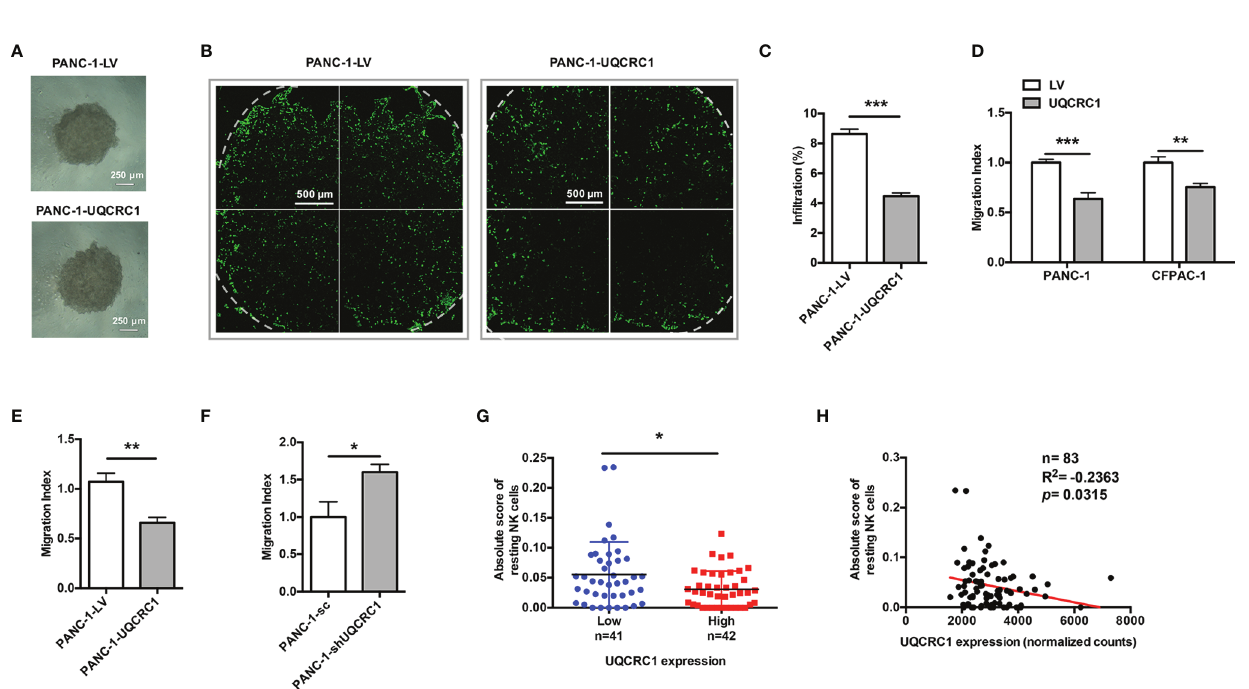
FIGURE 2 | UQCRC1 expressed in cancer cells impairs the migration and in fi ltration of NK cells into PC. (A) Microscopic images of UQCRC1-overexpressing and control PANC-1 spheroids (magni fi cation 4x). Scale bar = 250 m m. (B) The confocal microscopic images of PANC-1 spheroids after co-culture with NK-92MI cells at an E: T ratio of 2: 1 for 24 h. Scale bar = 500 m m. (C) Flow cytometric analyses of the proportions of NK-92MI cells in fi ltrated in the spheroids after 24 h of co- culture. (D) Transwell migration assay of NK-92MI cells toward the culture supernatant from UQCRC1-overexpressing or control PC cells. (E) Transwell migration assay of primary NK cells toward the culture supernatant from UQCRC1-overexpressing or control PANC-1 cells. (F) Transwell migration assay of NK-92MI cells toward the culture supernatant from UQCRC1-knockdown or control PANC-1 cells. (G) Comparison of the in fi ltration of resting NK cells in PC samples grouped by UQCRC1 expression (n=83). (H) The correlation analysis between UQCRC1 expression and the in fi ltration of resting NK cells in PC samples (n = 83). All data are presented as the mean ± SD (n = 3 independent biological replicates unless otherwise indicated). *, p < 0.05; **, p < 0.01; ***, p <